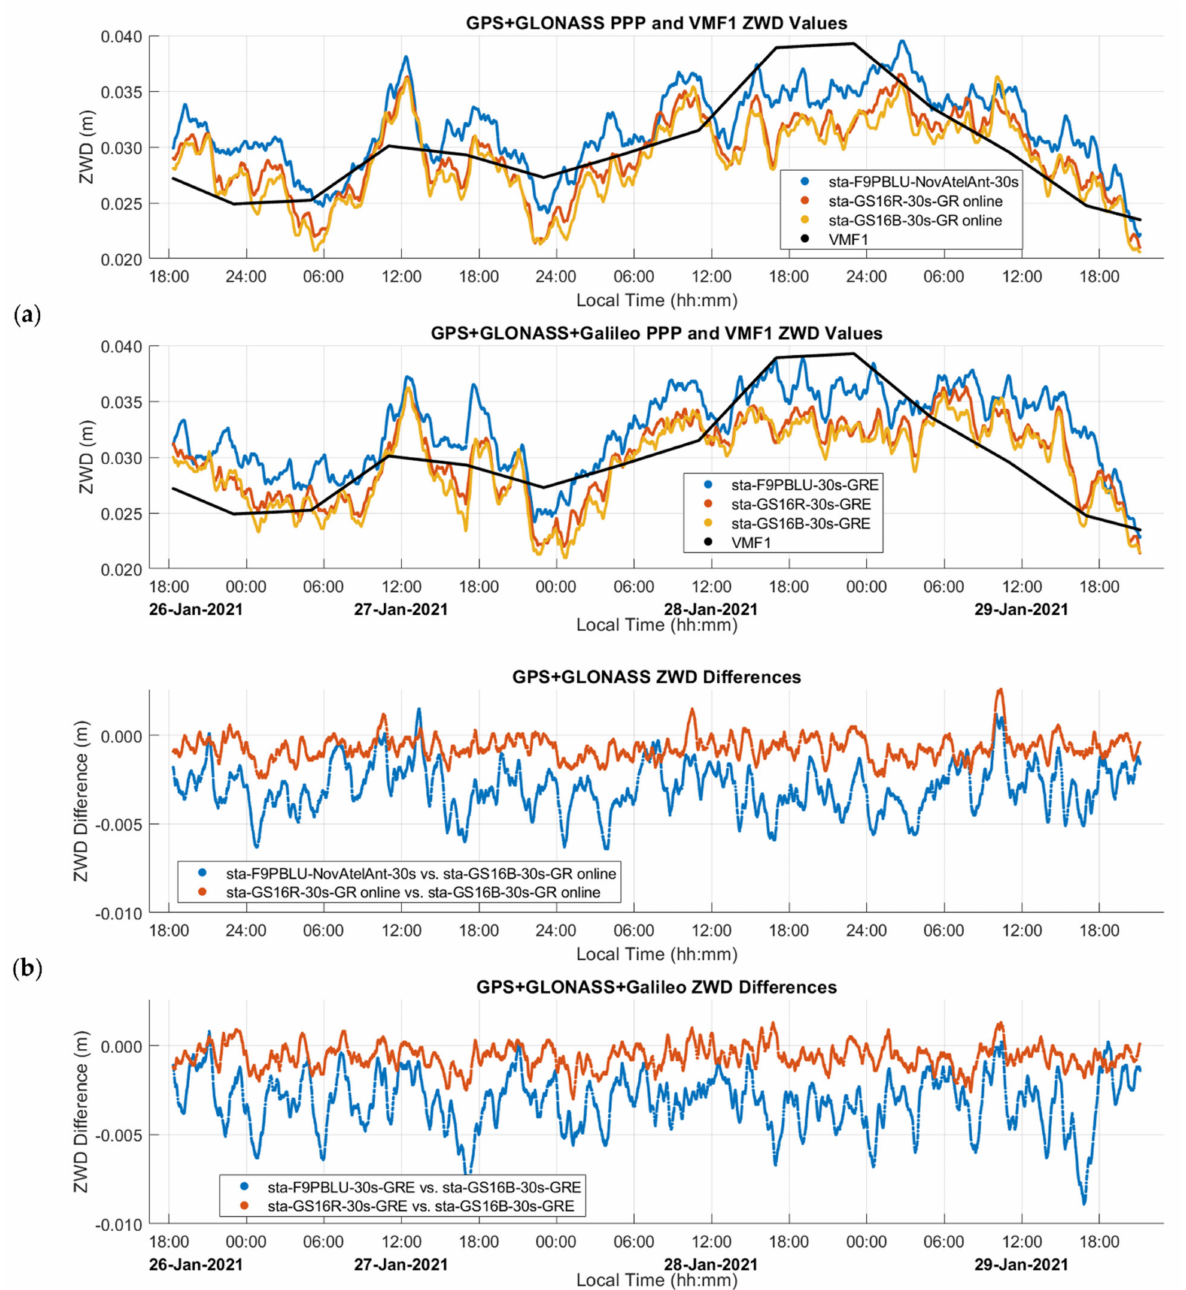
Figure 9. ( a ) Static dataset A ZWD profiles obtained by the three receivers and superimposed by the VMF1 profile for GR and GRE constellations; ( b ) The corresponding ZWD differences between receivers and solutions. Local time is UTC −